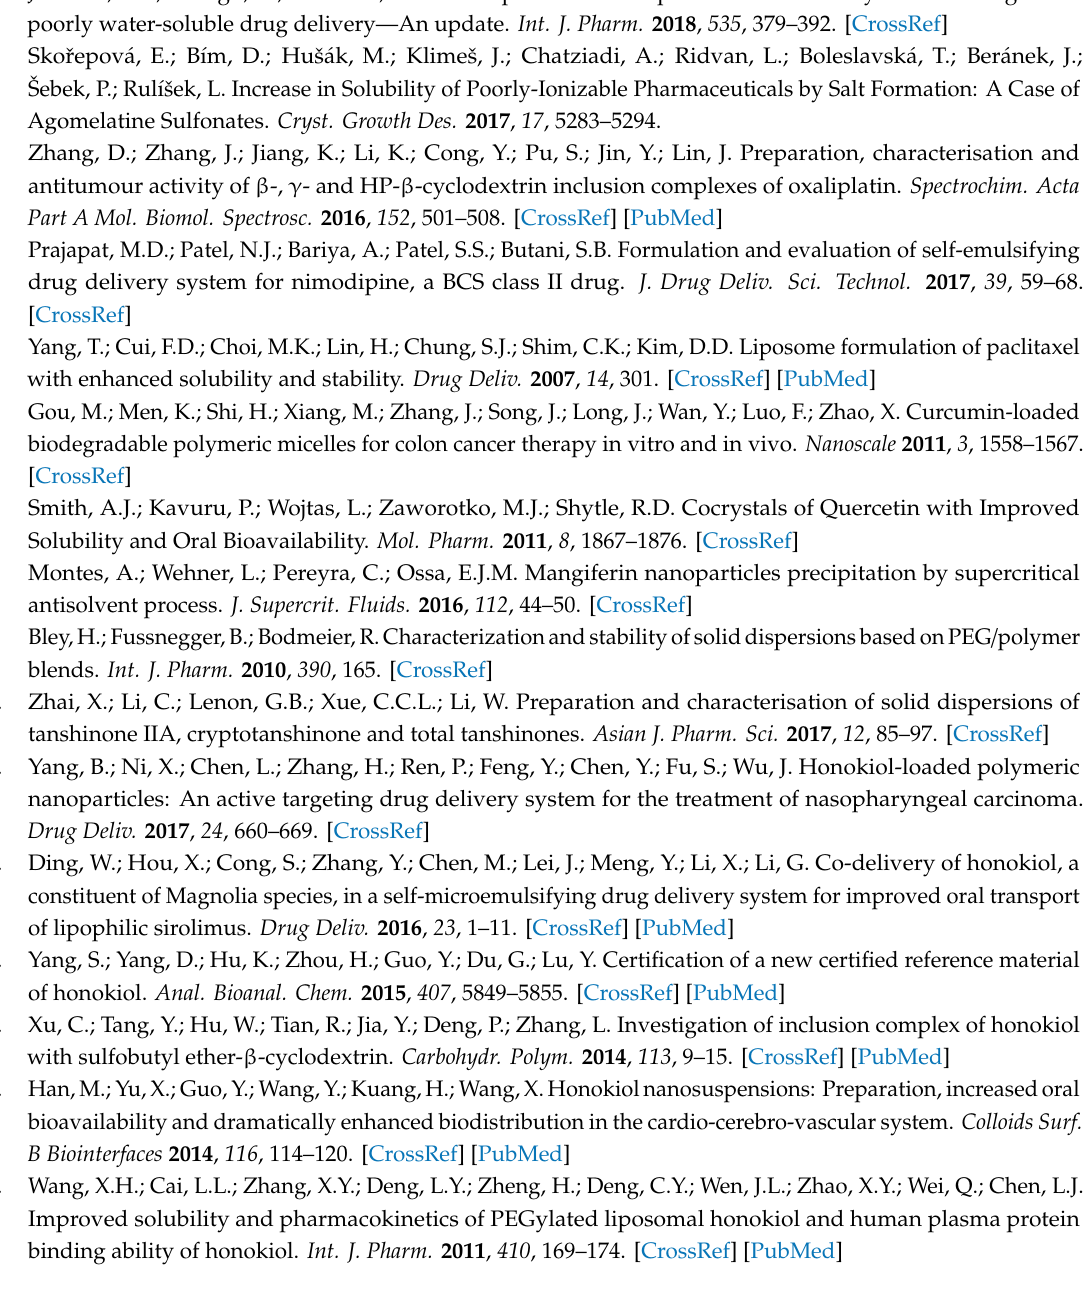
Figure S1: XRD diagram of the SDs of the HK prepared at di ff erent time, (a) a week ago, and (b) 16 months